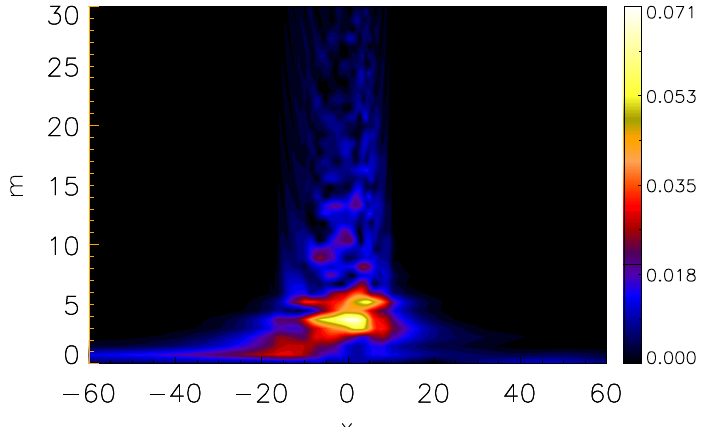
Figure 2. Spectrum of the energy flux density F x along the y direction for each x point in the ( x , k y ) plane at t = 146 for the case V 0 = 3.